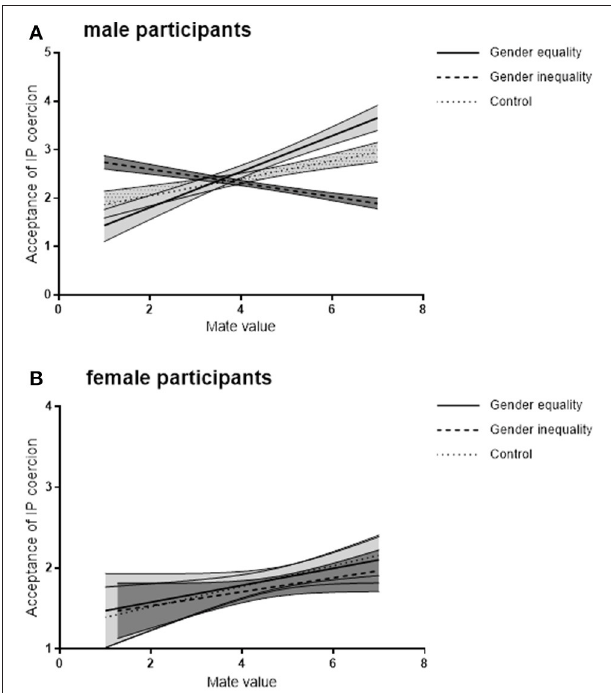
FIGURE 1 | Acceptance of male-to-female intimate partner coercion as a function of mate value and gender equality, for male (A) and female (B) participants. Bands are 95% confidence intervals. To account for random effects, the dependent variable is the predicted value yielded from the models in Table 1 .